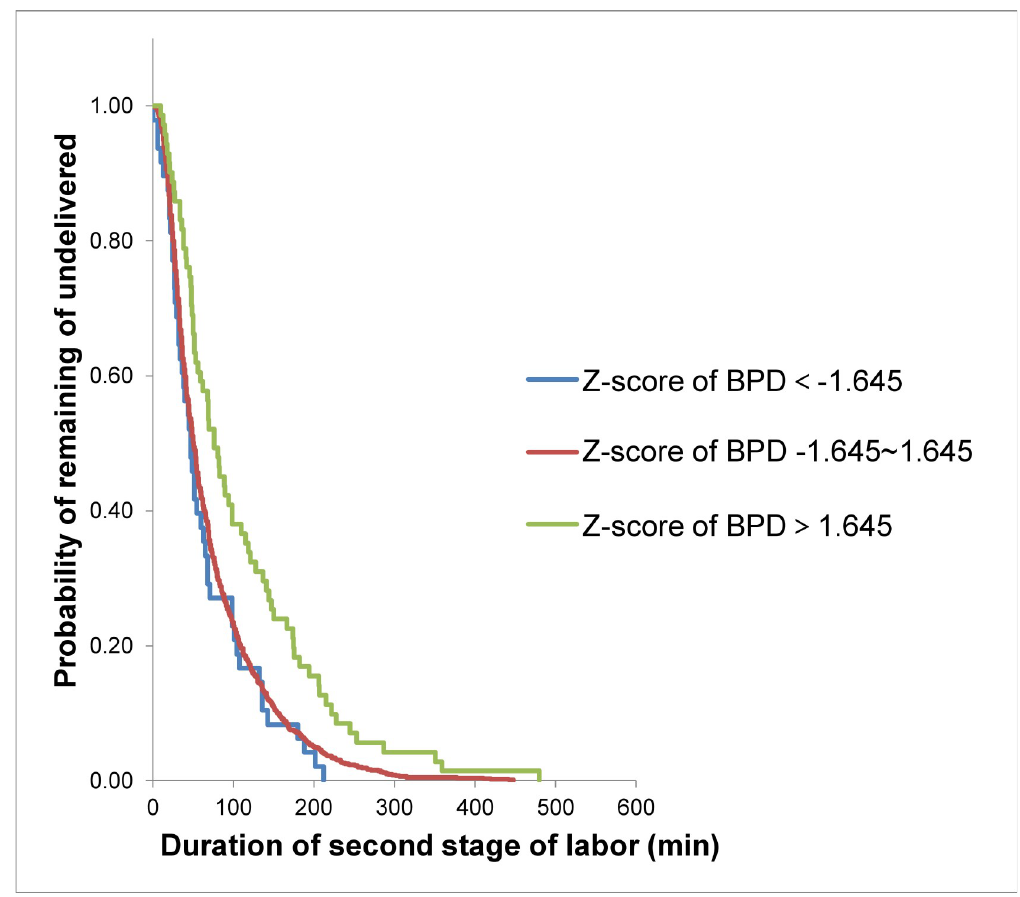
Fig 1. Kaplan-Meier analysis of the duration of second stage of labor according to Z-score of BPD in nulliparous women.